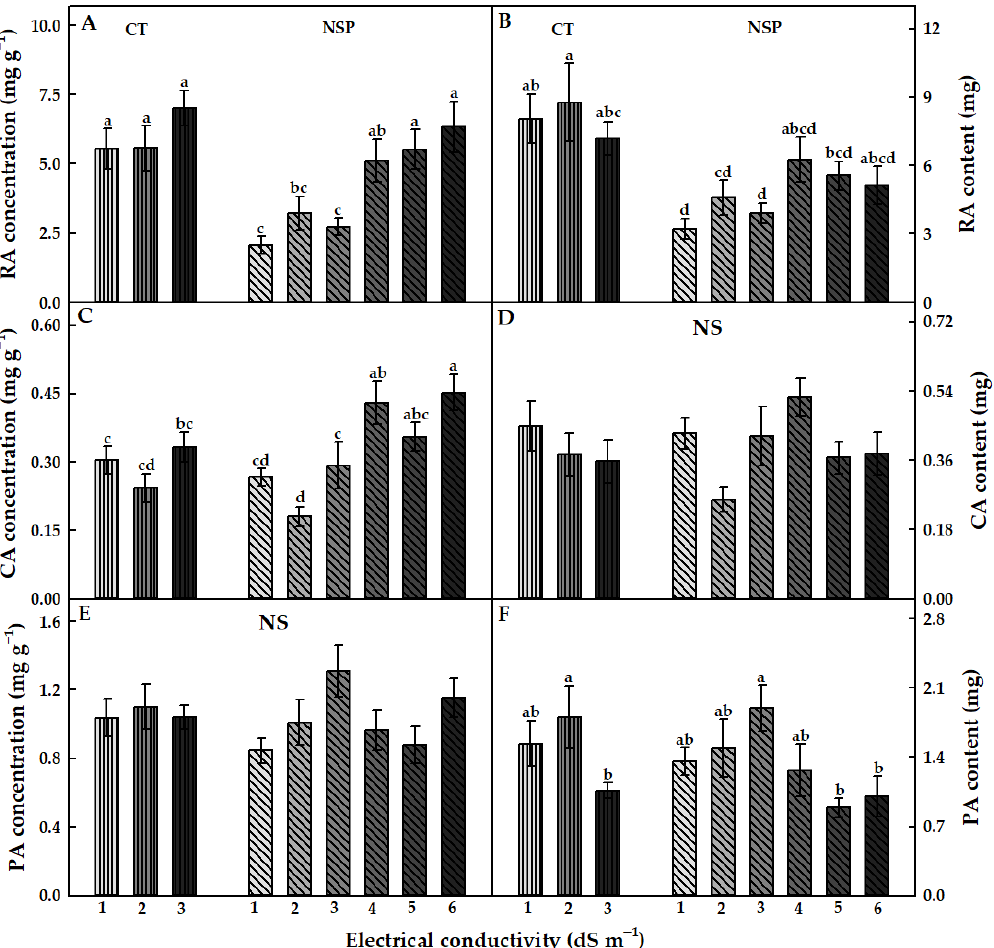
Figure 6. RA, CA, and PA concentration ( A , C , E ) and content ( B , D , F ) of red perilla plants grown under various EC levels of greenhouse nutrient solution (CT) and the newly-developed nutrient solution for red perilla (NSP) after 7 weeks of transplanting. Different letters indicate significant difference at p < 0.05 ( n = 6). NS means no statistically significant